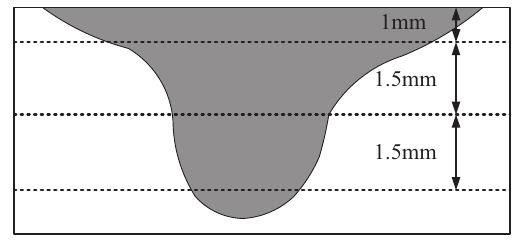
Figure 10: Schematic of the hardness testing lines.